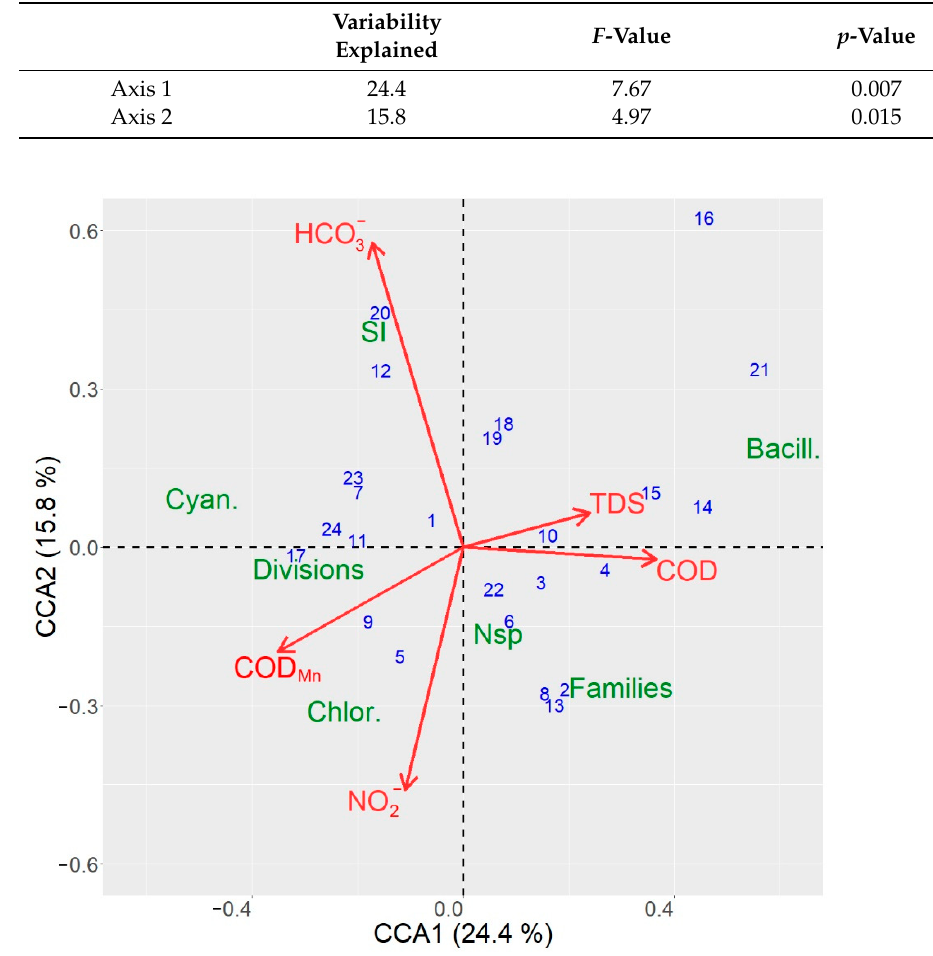
Figure 10. CCA ordination diagram of site scores, phytoplankton community structure parameters and selected environmental variables (represented by arrows). Only the significant explanatory environmental variables ( p < 0.05) are